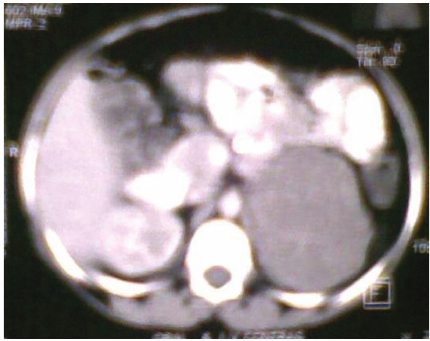
Figure 4: Enlarged view of CT scan image in cross section, showing a large well-circumscribed mildly enhancing mass having few calcification at left suprarenal